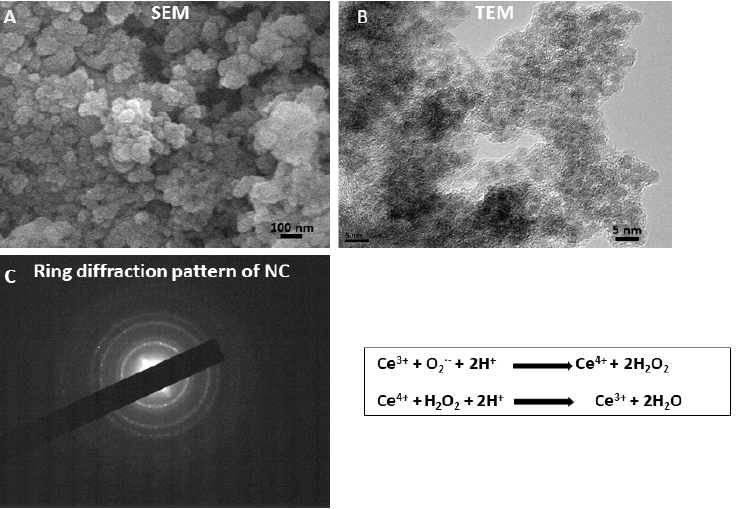
Figure 2. Characterization of NC. ( A , B ) represents the SEM ( A ) and TEM images of NC ( B ). ( C ) SAED pa tt ern of NC.